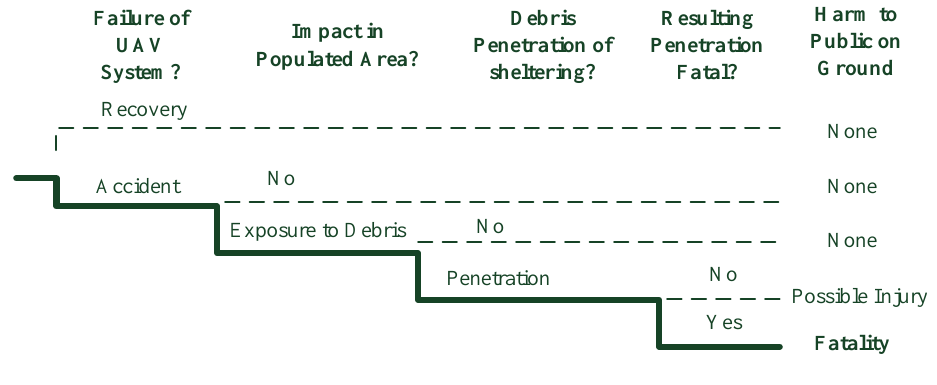
Figure 12. Ground impact model [21].